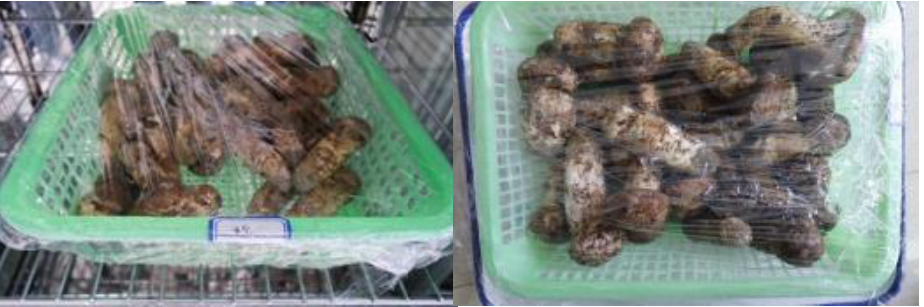
Figure 5. Display of matsutake